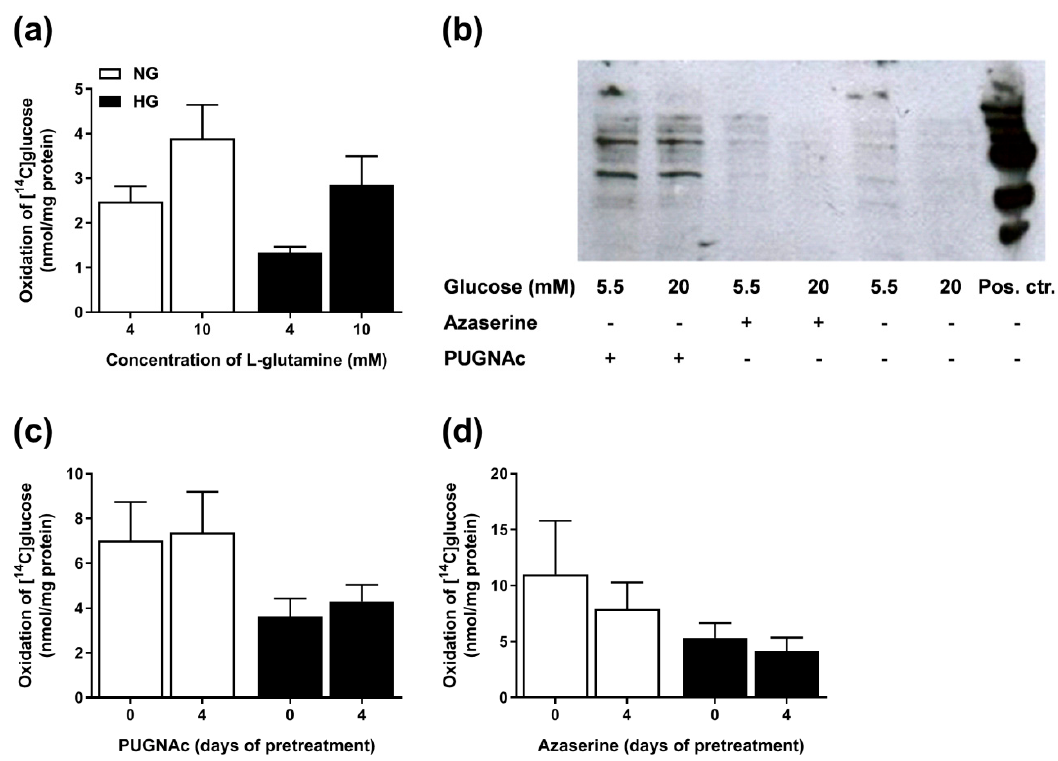
Figure 8. Involvement of the hexosamine pathway. ( a ) Myotubes were treated with 20 mM glucose (HG) or 5 mM glucose (NG) for four days in the presence of 4 mM (basal) or 10 mM l -glutamine before they were incubated with d -[ 14 C(U)]glucose (0.5 µ Ci / mL, 200 µ M) for 4 h. Glucose oxidation was measured as CO 2 trapped in a filter and counted by liquid scintillation. ( b ) E ff ects of the deglycosylation inhibitor PUGNAc (100 µ M) and the glycosylation inhibitor azaserine (20 µ M) in protein lysates from HG and NG cells. The inhibitors were added together with HG the last four days of the di ff erentiation period. Aliquots of 15 µ g cell protein from total cell lysates, including a positive control (cell lysate A549), were electrophoretically separated on 10% polyacrylamide gels, followed by immunoblotting with specific antibody for O -GlcNAc. One representative Western blot from three individual experiments (n = 3) is shown. ( c ) E ff ect of the deglycosylation inhibitor PUGNAc (100 µ M) on glucose oxidation. ( d ) E ff ect of the glycosylation inhibitor azaserine (20 µ M) on glucose oxidation. Results are presented as means ± SEM in nmol / mg protein from three individual experiments (n =